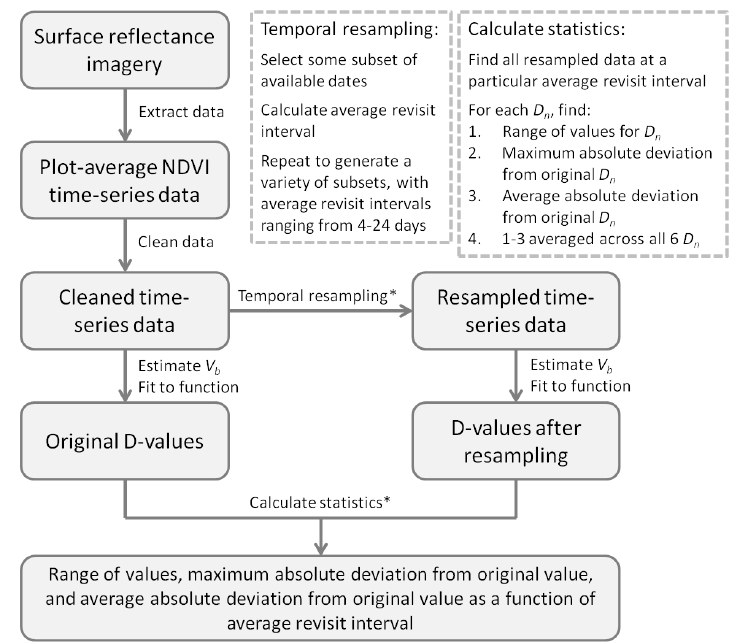
Figure 3. Visual representation of the temporal resampling procedure and analysis. All steps are described in more detail in the Methods section. Note: This analysis was performed separately for each of the 32 plots shown in Figure 1. After the end results (range, maximum absolute deviation, and average absolute deviation as a function of revisit interval) were obtained, they were averaged across all 32 plots.